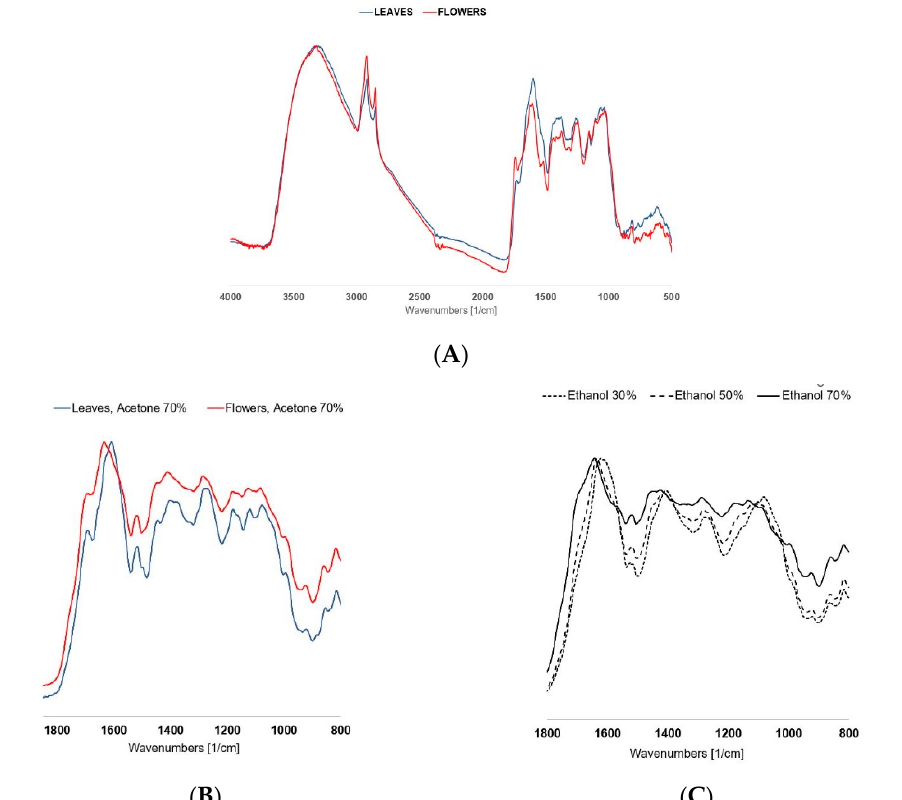
Figure 4. FTIR DRIFT spectra. ( A ) T. vulgare parts: flowers and leaves; ( B ) Extract in 70% acetone of T. vulgare parts: flowers and leaves; ( C ) Extract in 70%, 50%, and 30% ethanol of T. vulgare flowers.